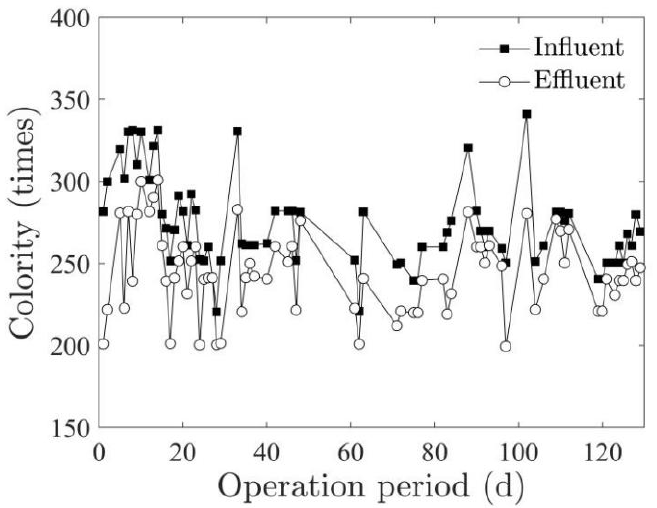
Figure 4. Variation of colority of the influent and effluent wastewater during the ABR operation period.